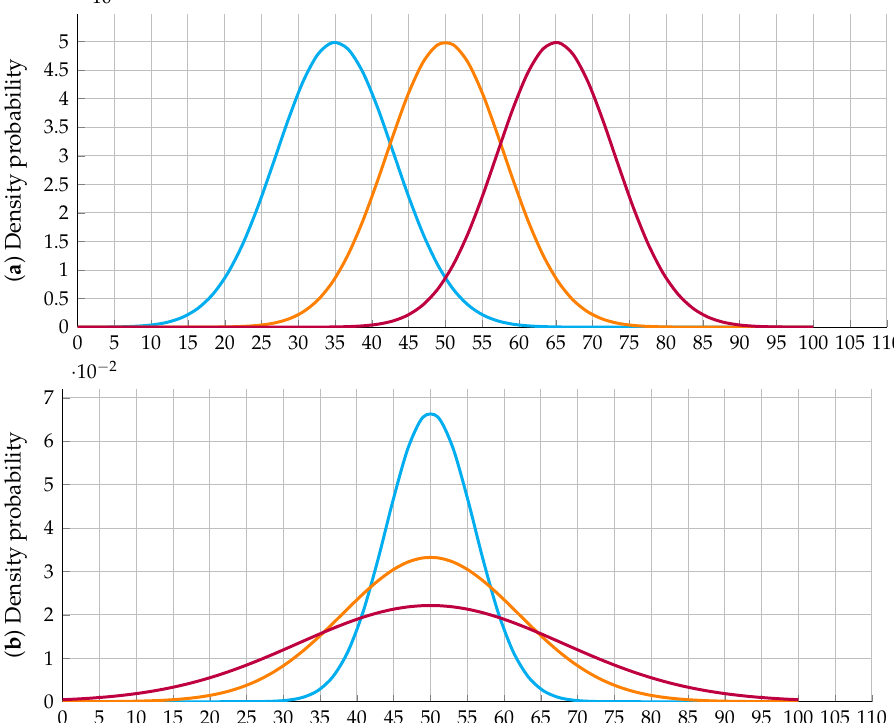
Figure 1. Variations in the Gaussian distribution as a function of the changes in the µ and δ parameters: ( a ) behavior of the Gaussian distribution when δ is fixed, and µ is varied; ( b ) behavior of the Gaussian distribution when µ is fixed, and δ is